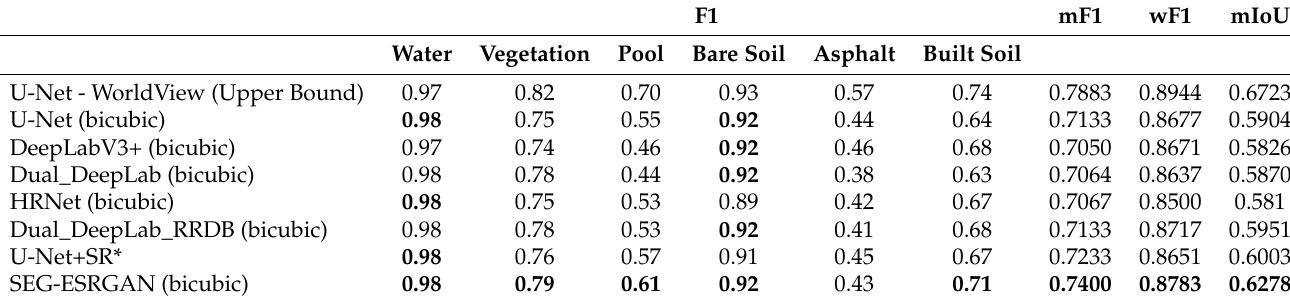
Table 5. Segmentation metrics obtained with the test set of the dataset. Best values in bold. mF1 refers to the mean F1 value, wF1 refers to the weighted mean F1 value and mIoU is the mean IoU. F1 mF1